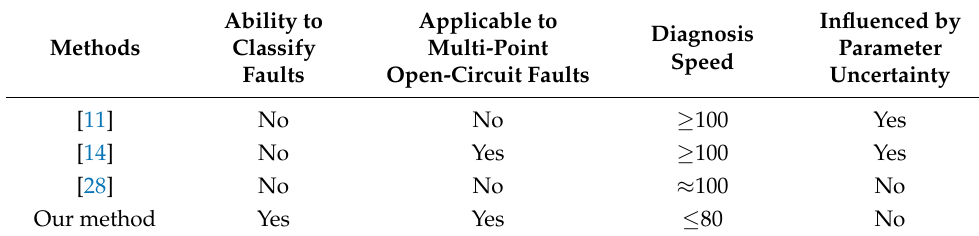
Table 2. Comparison of different diagnostic